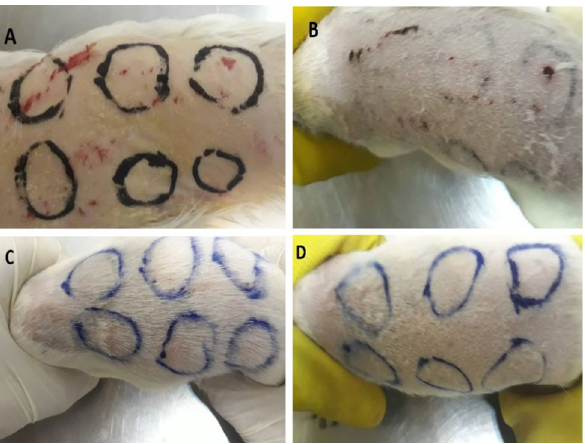
Figure 6. test irritation ( A ) the first day after removing the Fur (without exposure with colloid) ( B ) 1 weak after exposure with the synthesized colloid ( C ) 2 weeks after exposure ( D ) 4 weeks after exposure.